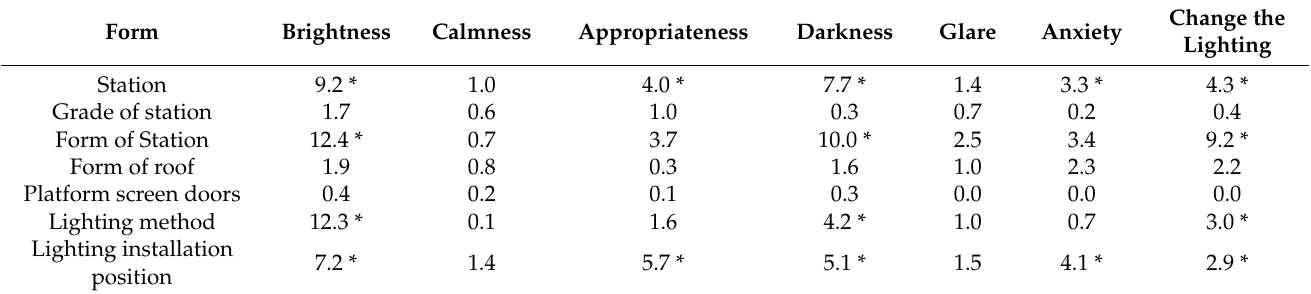
Table 4. ANOVA results according to platform type classification (F value, * significant